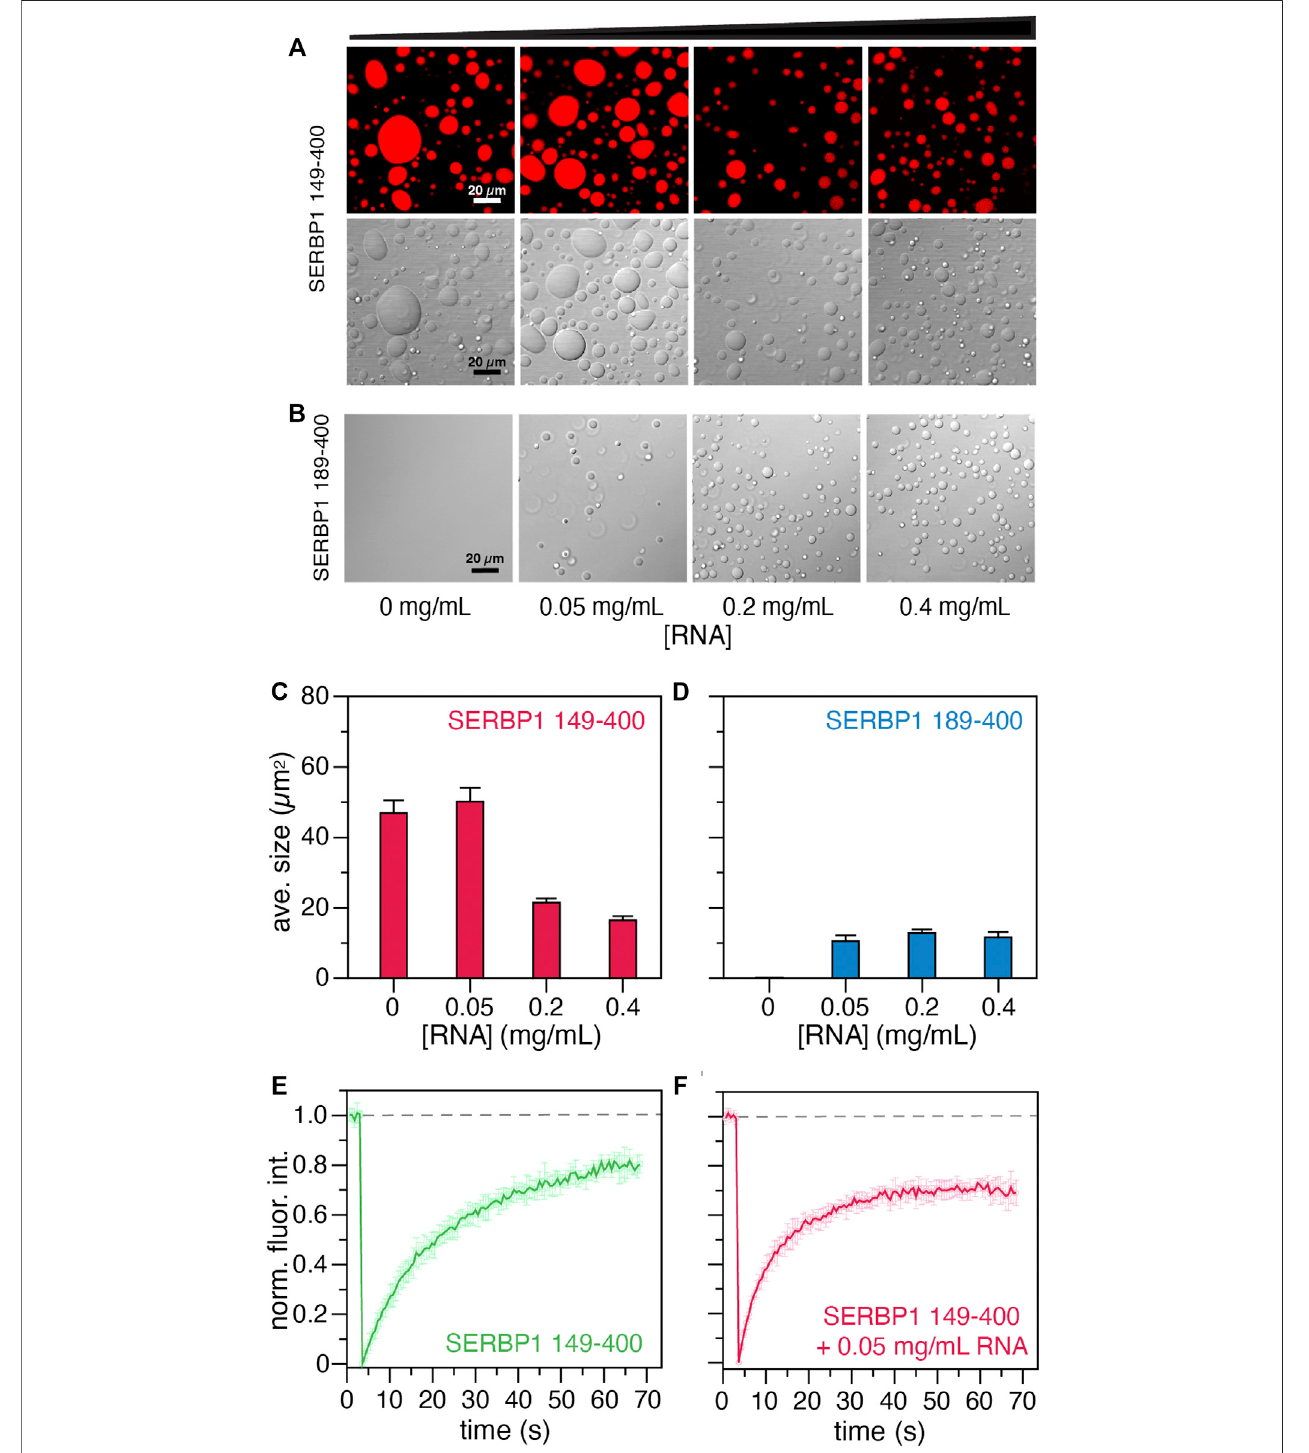
FIGURE 6 | Phase separation assays of SERBP1 149 – 400 and SERBP1 189 – 400. Effect of RNA on the LLPS propensity of 12 µM (A) SERBP1 149 – 400 or (B) SERBP1189 – 400 inbuffer containing13% (v/v)glyceroland 13%(w/v) PEG3000. TorulayeastRNAwastitrated intoSERBP1 protein solutions to fi nalconcentrations rangingfrom0to0.4 mg/ ml.Theaveragedropletsizes(µm 2 )shownfor (C) SERBP1149 – 400and (D) SERBP1189 – 400werederivedfromthreeindependentimages. Normalized fl uorescence recovery after photobleaching (FRAP) pro fi les of 12 µM SERBP1 149 – 400 in the (E) absence or (F) presence of 0.05 mg/ ml torula yeast RNA. Dashed line indicates average the fl uorescence before photobleaching.